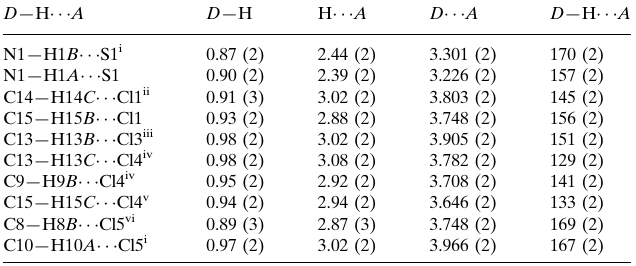
Hydrogen-bond geometry (A˚ , (cid:3)